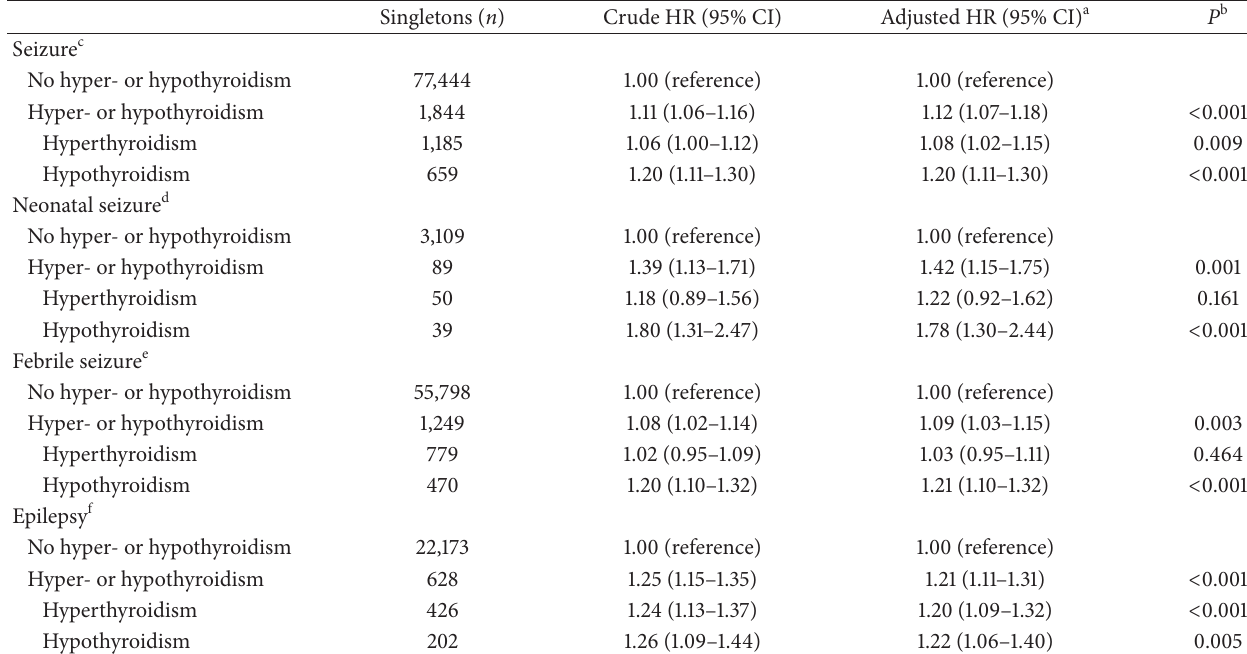
Table 2: Hazard ratio (HR) with 95% confidence interval (95% CI) for seizure in singletons born in Denmark, 1978–2006, according to maternaldiagnosisofhyper-orhypothyroidismregisteredintheDanishNationalHospitalRegister(DNHR)beforeJanuary1,2007.Reference is singletons born to mothers with no diagnosis of thyroid dysfunction registered in DNHR before January 1, 2007. Singletons ( n